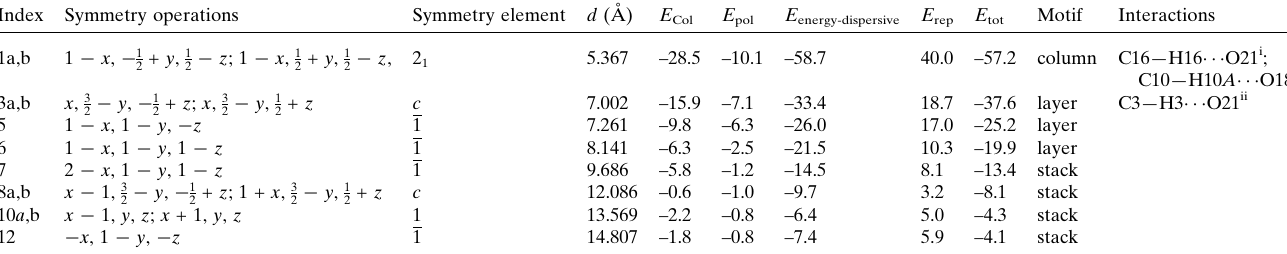
Table 2 PIXEL energies (kJ mol (cid:4) 1 ) for molecule/molecule interactions.